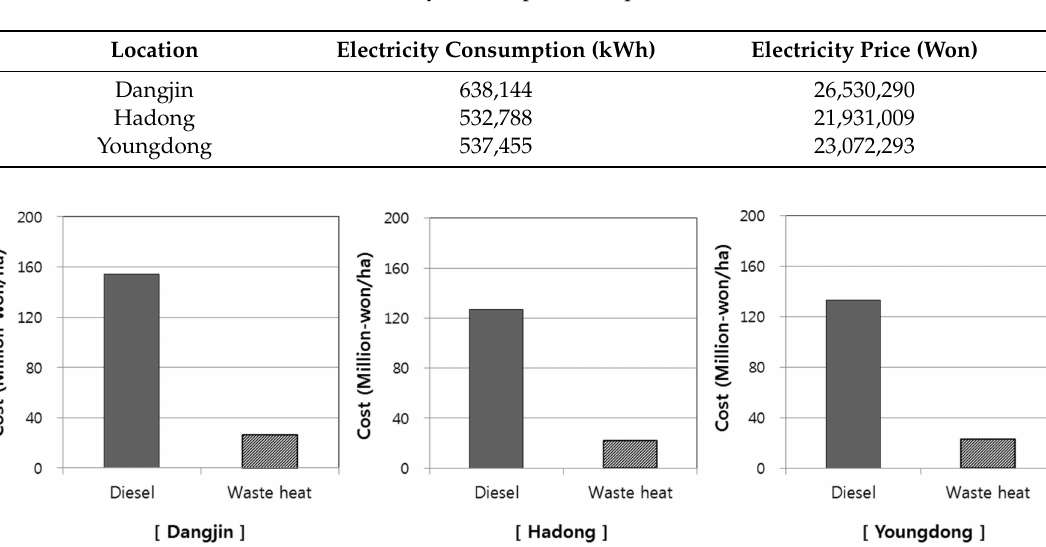
Table 10. Electricity consumption and price in each case.